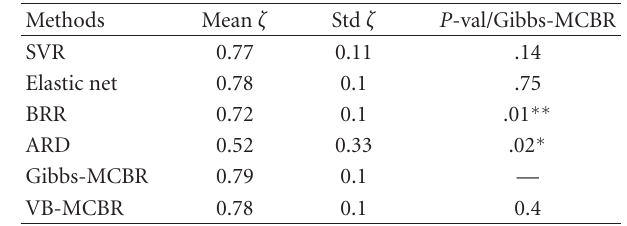
∗ Level of significance of the P -values. ∗∗ Level of significance of the P -values between 0.01 and